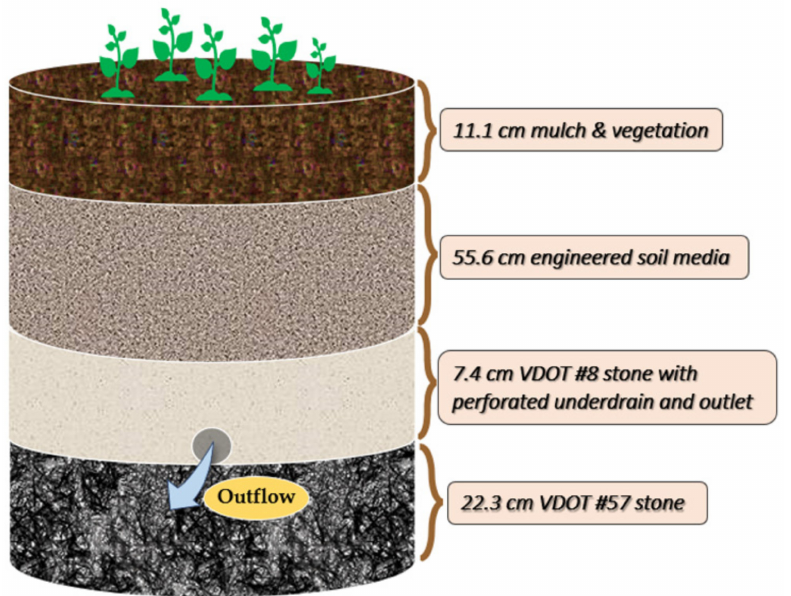
Figure 3. Engineered soil media column schematic in laboratory (created with Microsoft